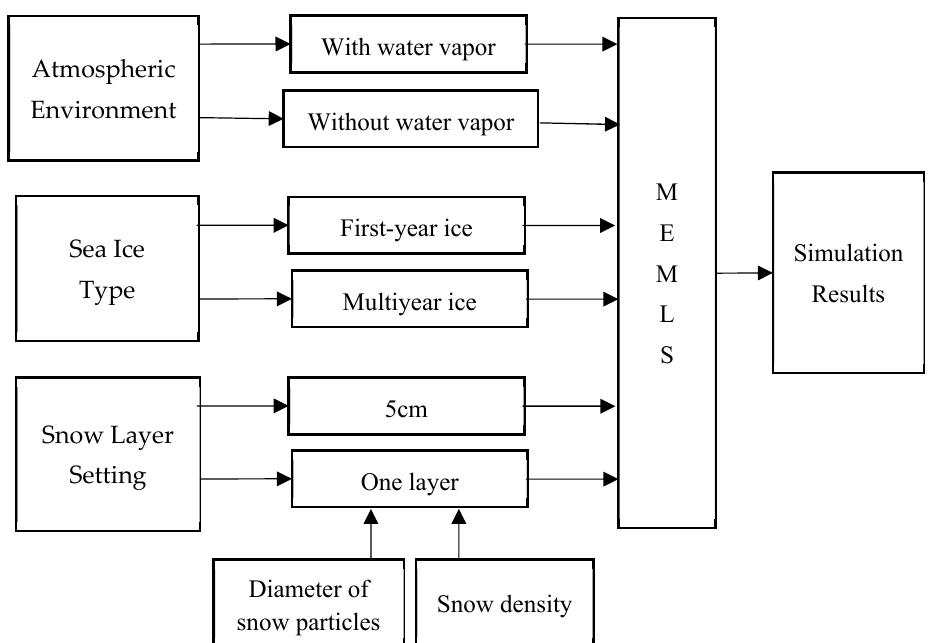
Figure 1. Combination of environmental variables in the simulation process.